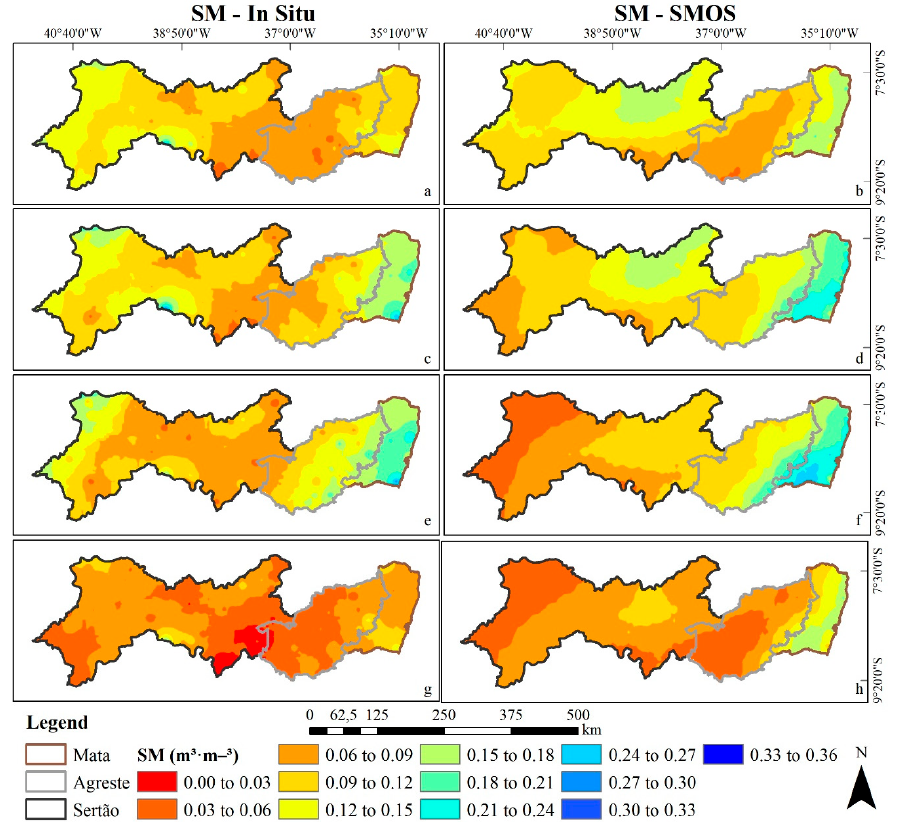
Figure 8. Soil moisture spatial distribution with ( a , c , e , g ) in situ and ( b , d , f , h ) SMOS data for the ( a , b )